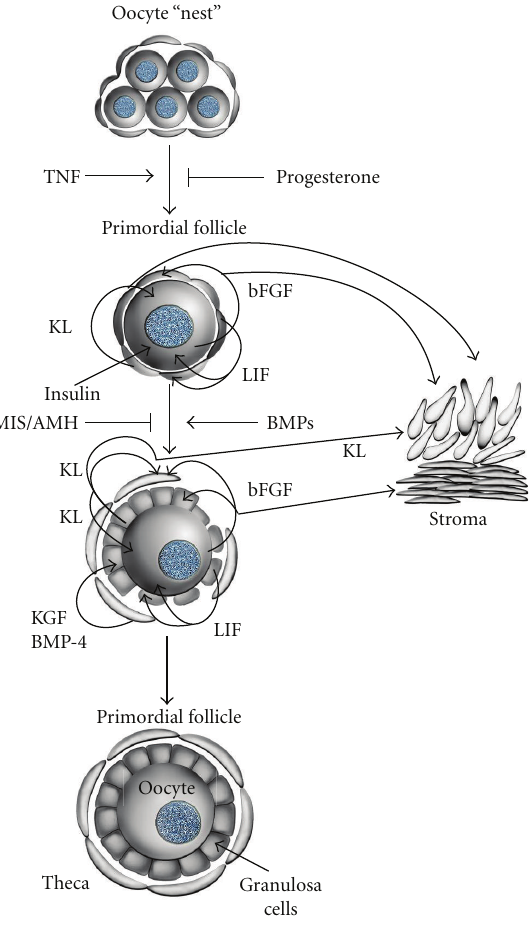
Figure 1: Cell interactions in primordial follicles [3, 6]. Proposed cell interactions in the development of primordial follicles and the e ff ect of the growth factors. Cell-cell interactions are mediated by tumor necrosis factor-alpha (TNF α ), Kit ligand (KL), basic fibroblast growth (bFGF), leukemia inhibitory factor (LIF), bone morphogenetic protein-4 (BMP-4), keratinocyte growth factor (KGF), insulin, and anti-Mullerian hormone (AMH). With permis- sion from M.